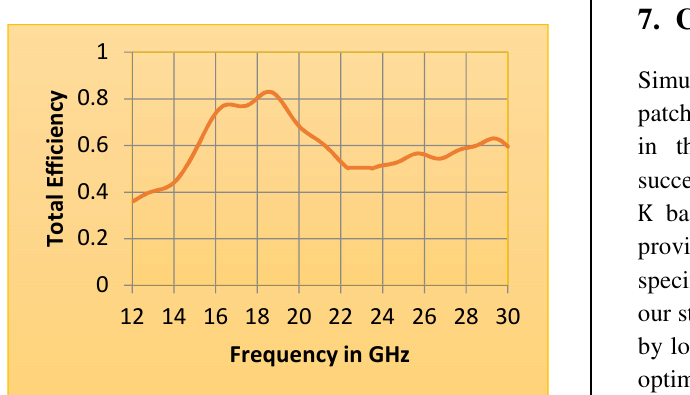
FIG. 13. SWR VERSUS FREQUENCY